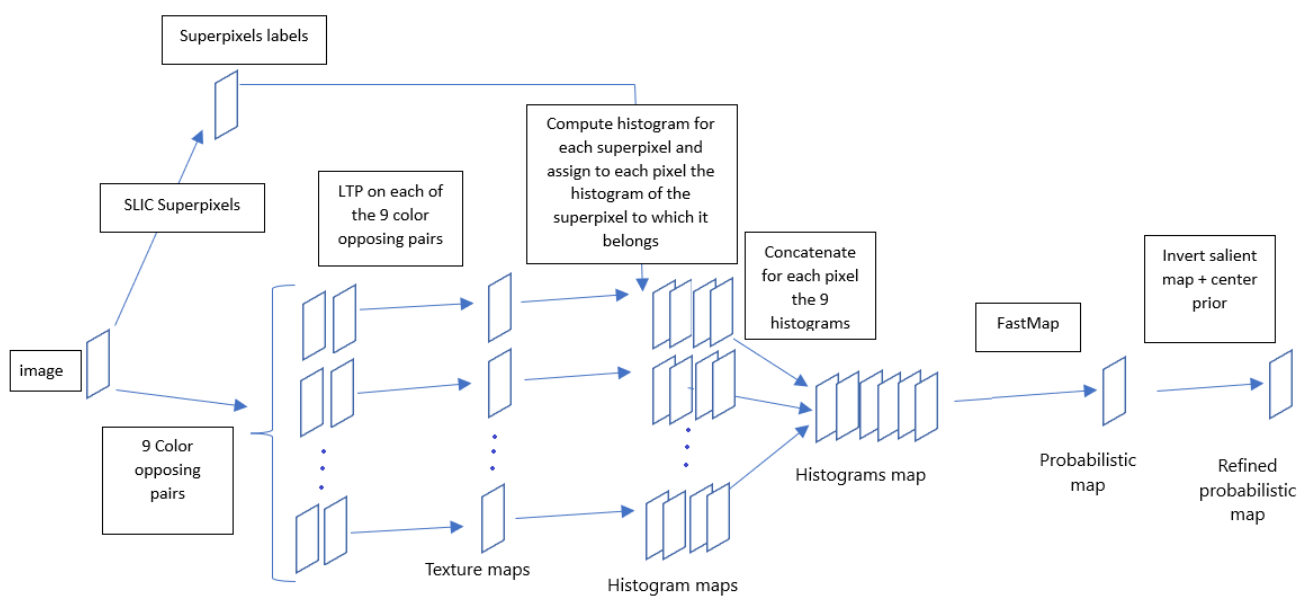
Figure 3. Proposed model steps to obtain the refined probabilistic map from a color space (e.g., RGB: